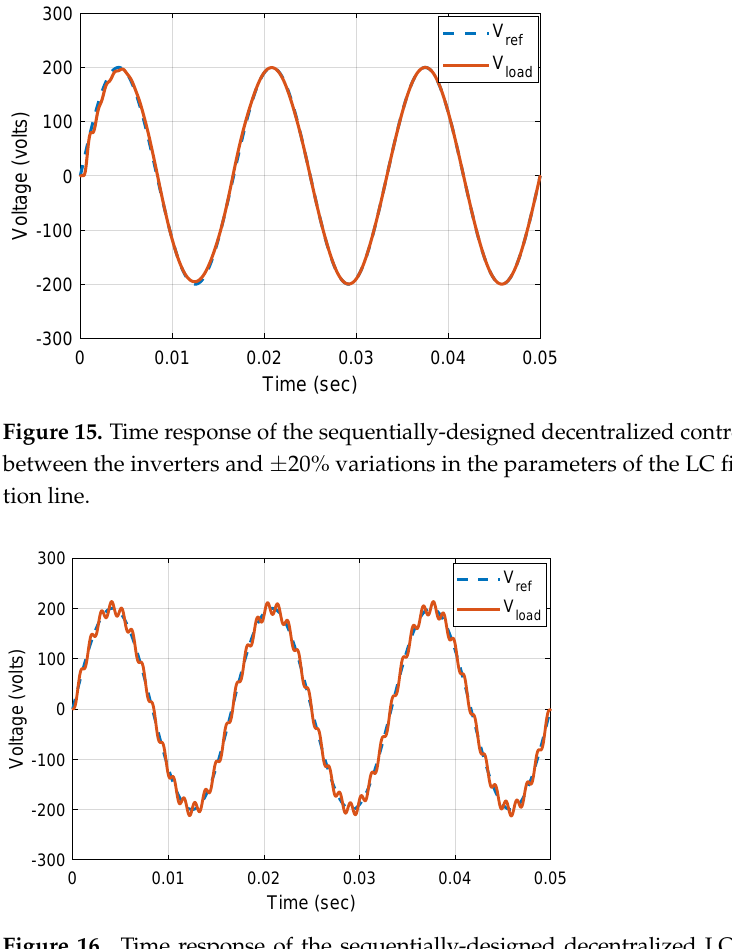
Figure 16. Time response of the sequentially-designed decentralized LQG controllers for 500 (m) distance between the inverters and ± 20% variations in the parameters of the LC filters and the interconnection